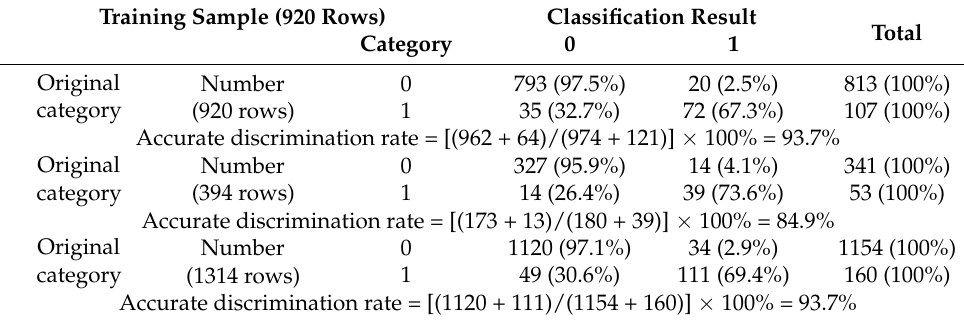
Table 16. Back-propagation neural network judgments. Training Sample (920 Rows) Classification Result